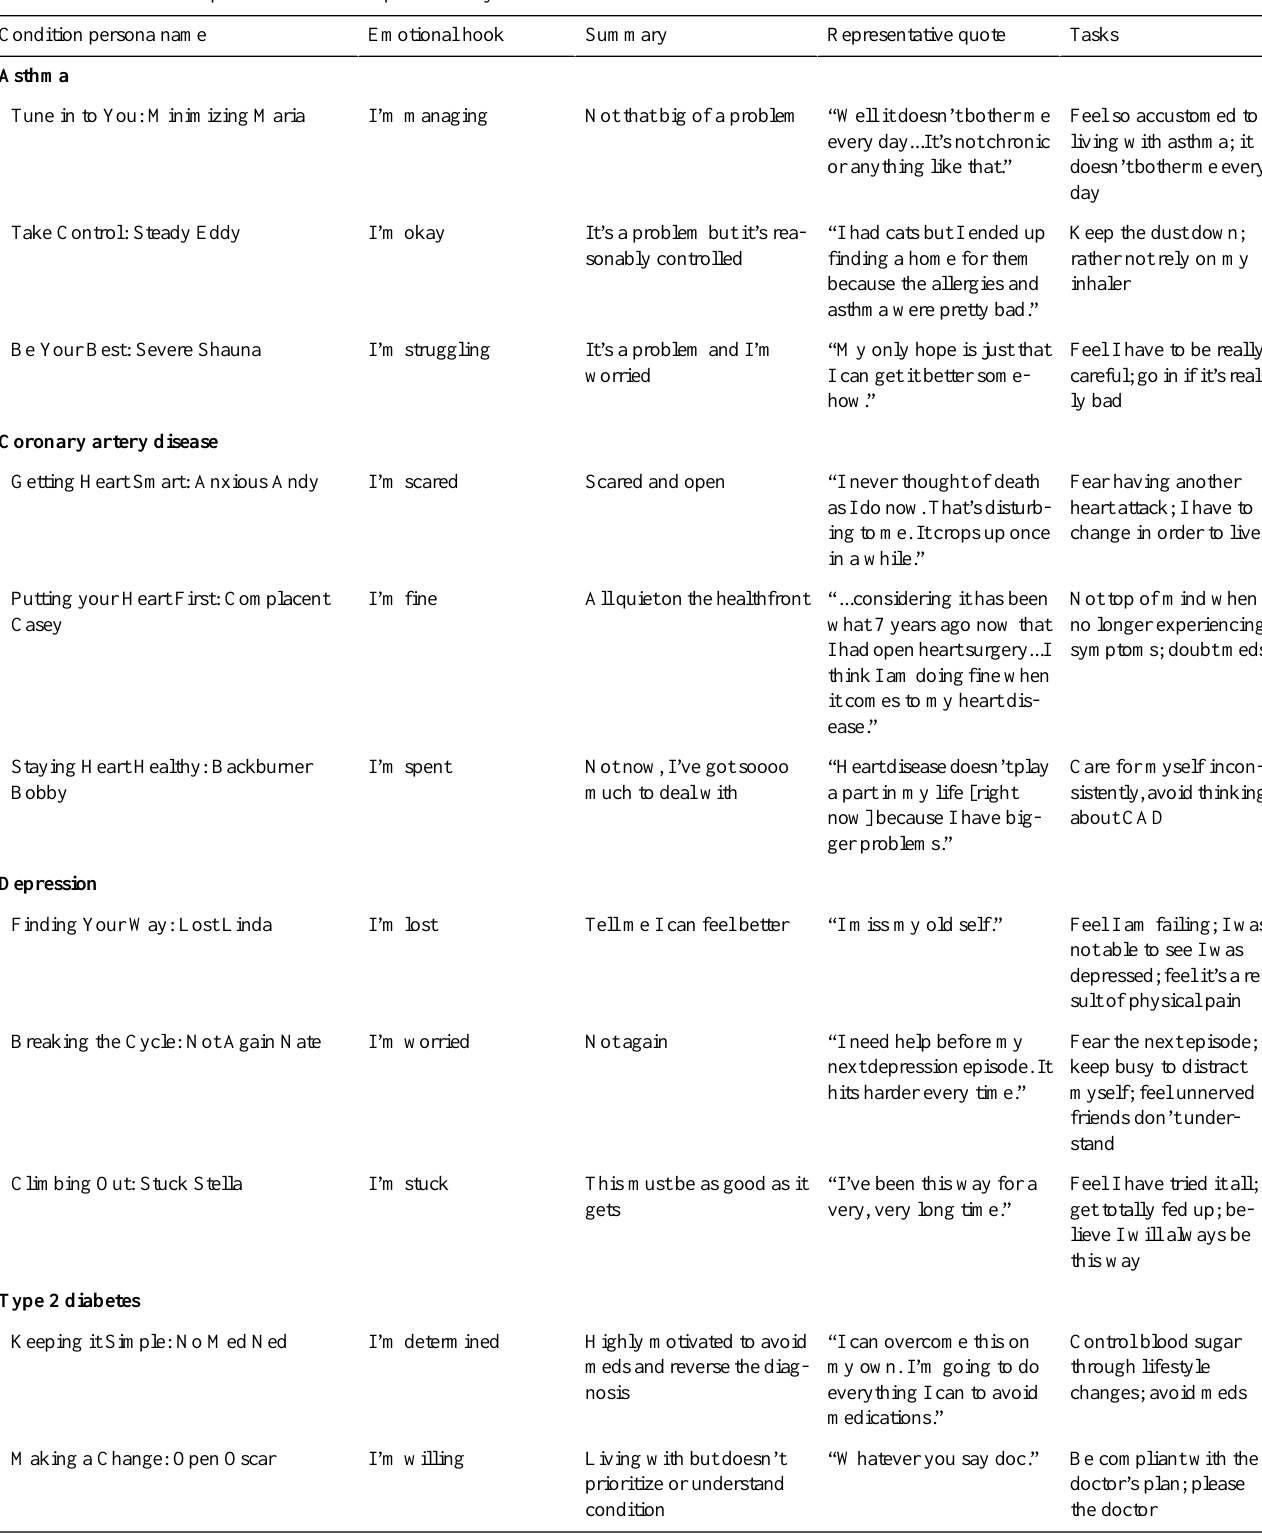
Table 2. Chronic disease personas with descriptions of key